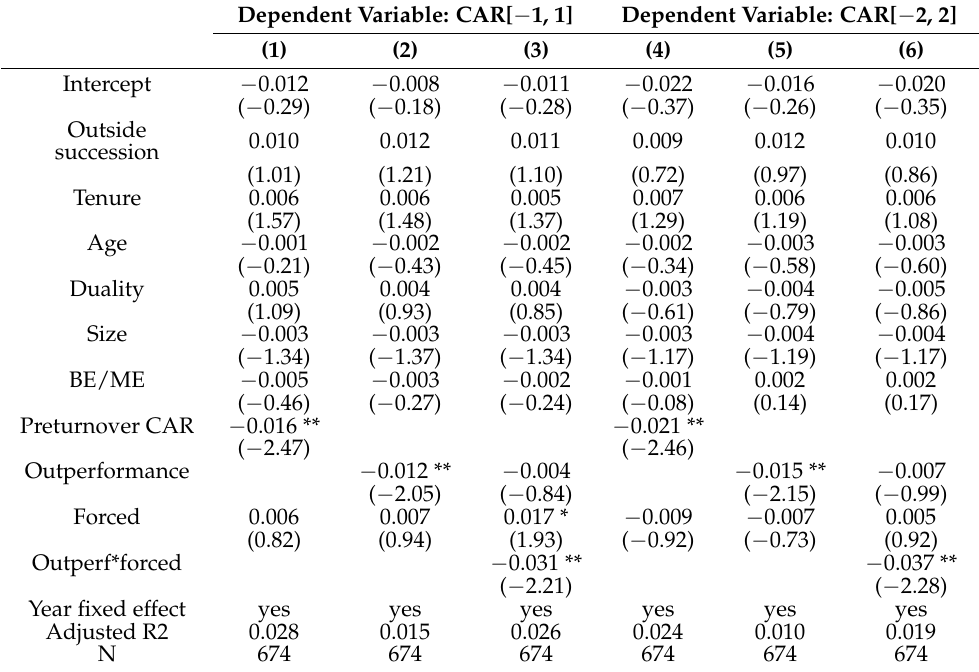
Table 4. Previous performance impact on price reactions of CEO turnover